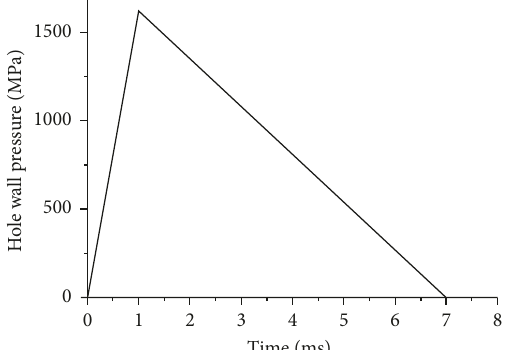
Figure 6: Time history diagram of equivalent load (with a peak value of